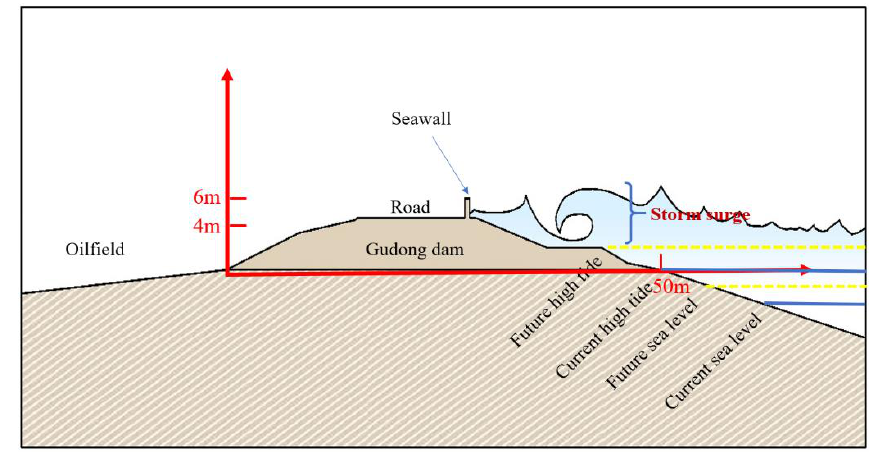
Figure 23. Schematic diagram of the inundation assessment in this study.